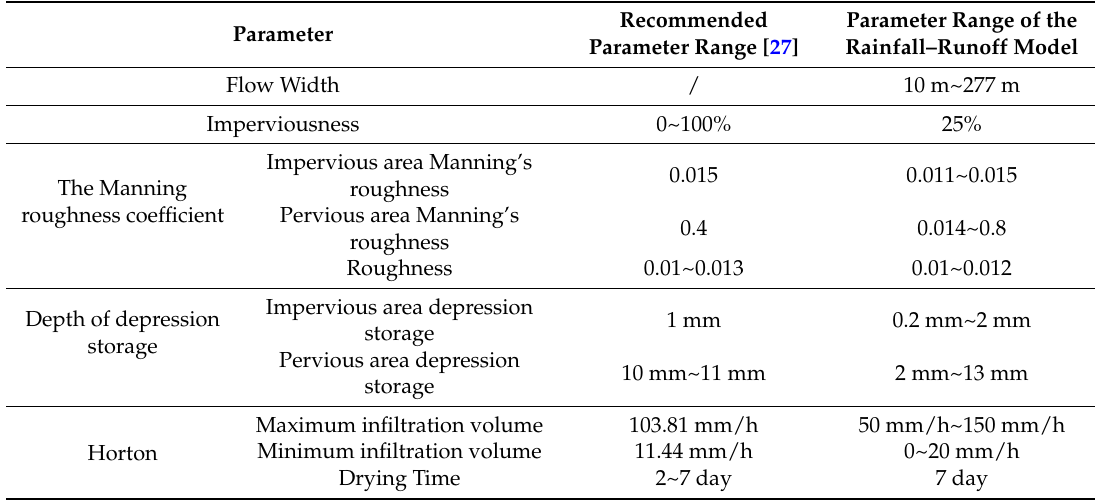
Table 3. Values and ranges of the main sensitivity parameters of the rainfall–runoff model.